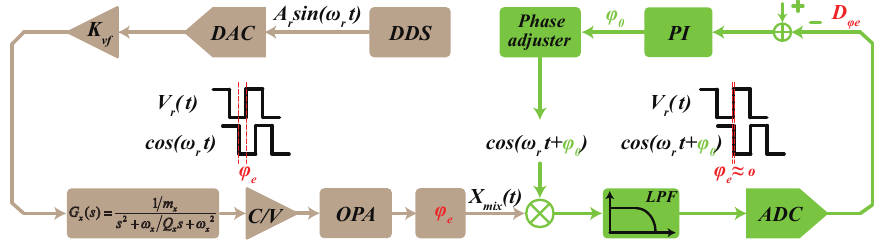
Figure 6. The functional block diagram of the compensation